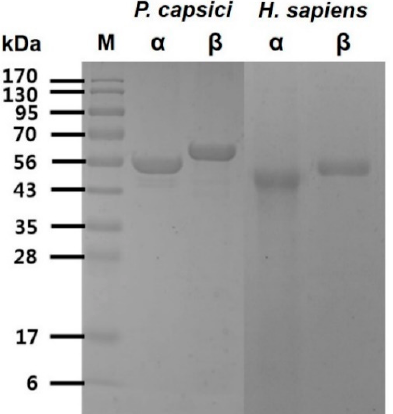
Figure 1. The SDS-PAGE analysis of the purification of P. capsici and H. sapiens α , β -tubulin. Electrophoresis was performed using a 12% polyacrylamide gel, and the staining of proteins was carried out using Coomassie blue R-250.